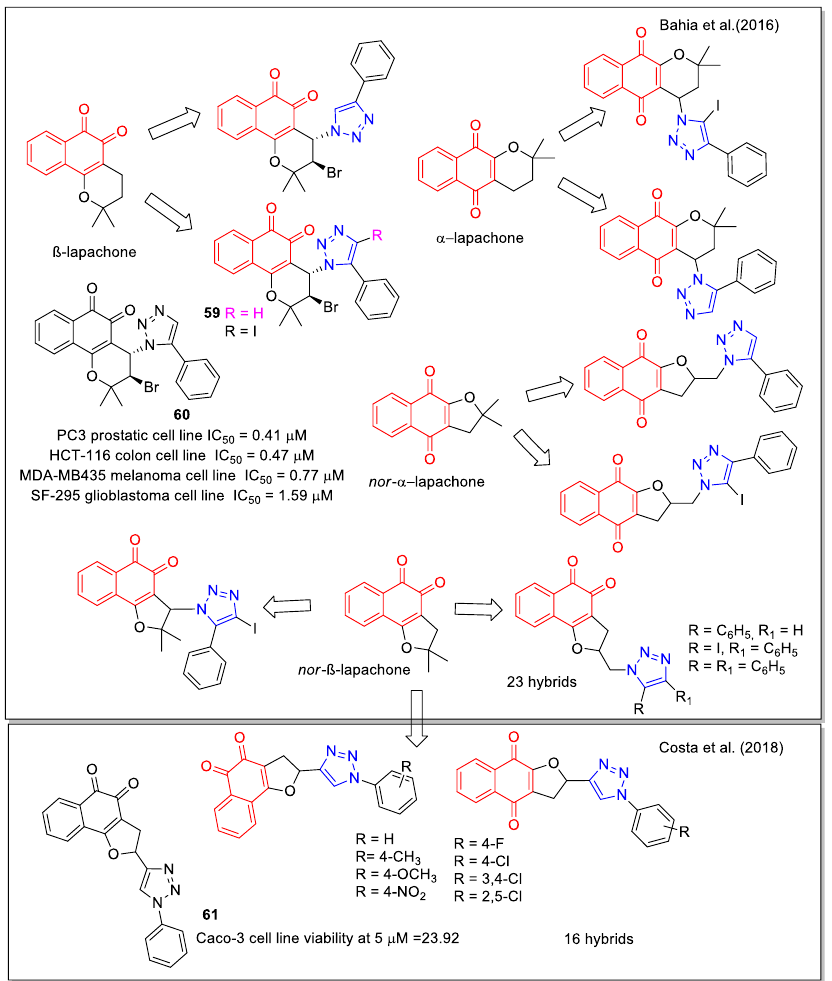
Figure 23. Lapachone or nor-lapachone – substituted 1,2,3-triazole hybrids as reported by Bahia et al. [64], and by Costa et al. [65].